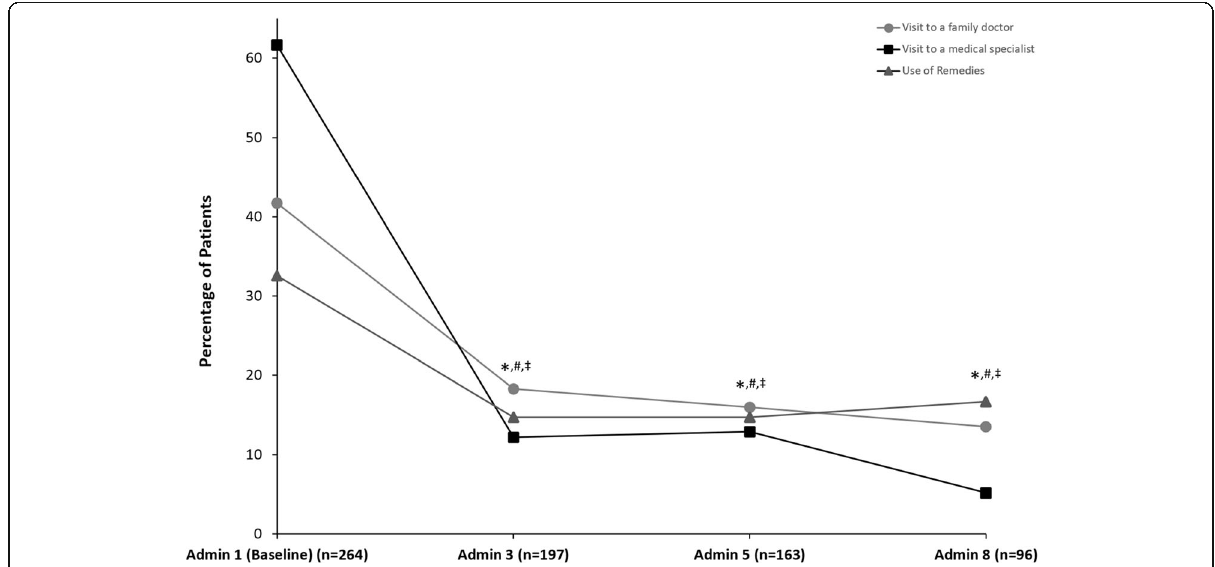
Fig. 3 Health economic questionnaire data from German patients in the SAF enrolled before 08 April 2014 showing percentages of patients who visited a family doctor ( ● ), visited a medical specialist ( ■ ), and used remedies, including massage, manual therapy, and physiotherapy ( ▲ ). Percentages are related to the number of patients at the respective visit. The reporting window for the baseline visit was the last 6 months; follow-up since the last visit. Non-overlapping 95% confidence intervals (CIs) at each time point vs. baseline are denoted by * for visits to a family doctor, # for visits to a medical specialist, and ‡ for use of remedies; non-overlapping 95% Cis show statistical